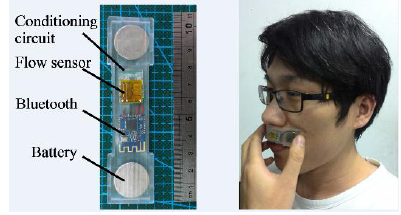
Figure 4. The prototype of developed monitor and demonstration of attaching it on the upper lip.